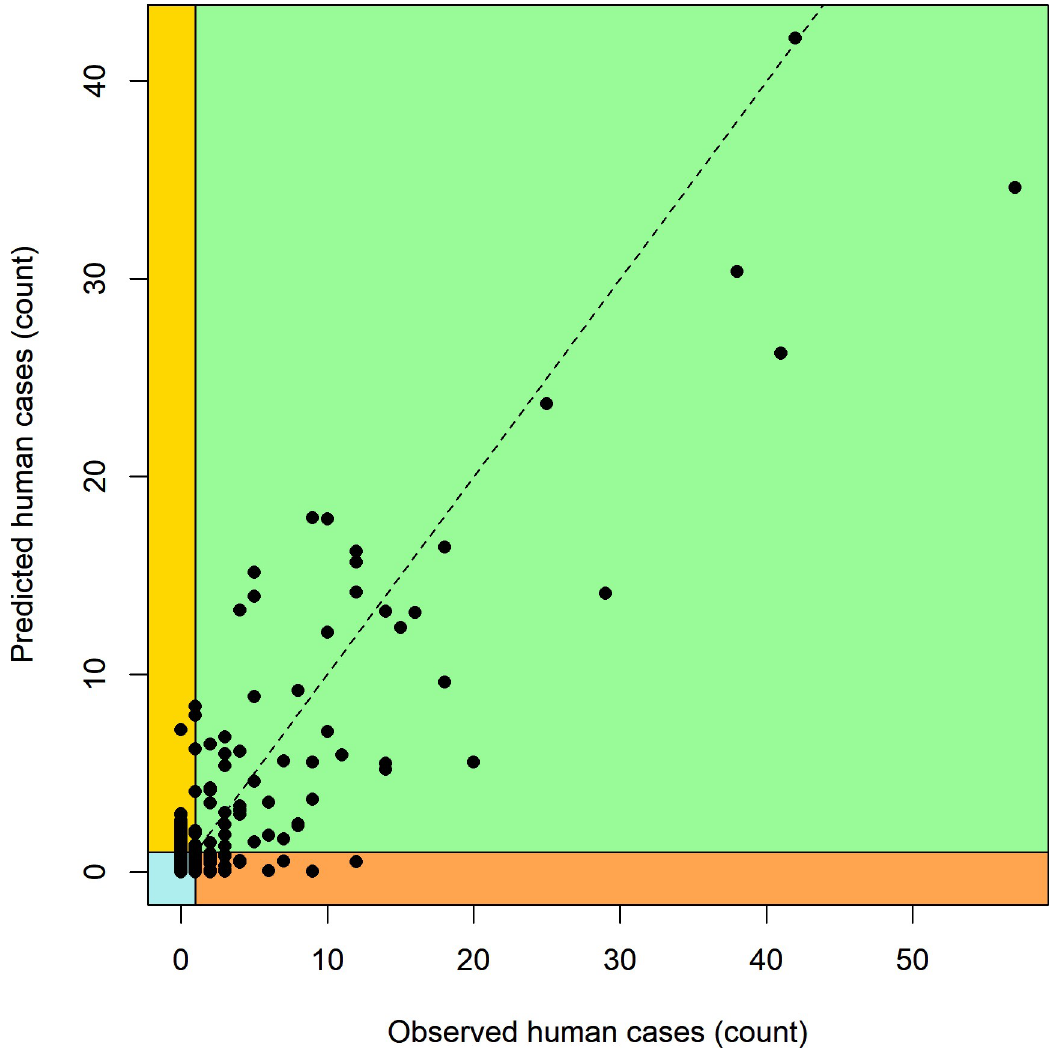
Fig 2. Observed number of human cases of WNV across all of New York and Connecticut vs. predicted number of human cases of WNV from the model using the entire data set. Background colors correspond to a classification of model predictions based on a threshold of 1 human case. Green corresponds to a correct prediction of one or more human cases (65 records, 7.4%), blue corresponds to a correct prediction of no human cases (704 records, 79.8%). Yellow corresponds to an error where the model predicts at least one human case, but none were observed (38 records, 4.3%), whereas orange corresponds to an error where the model predicts no human cases, but at least one was observed (75 records, 8.5%). Sensitivity (0.46) and specificity (0.95) were similar to the estimates for county-scale mosquito infection